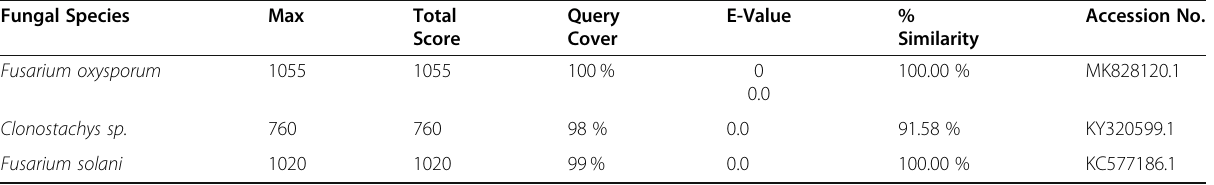
Query E-Value % Accession No. Score Cover Similarity 100.00 % MK828120.1 0.0